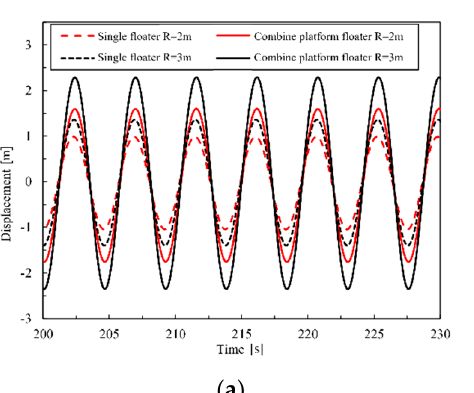
Figure 9. Motion amplitude of four groups of floater radii under regular waves with different frequencies: ( a ) R = 2 m & R = 3 m; ( b ) R = 4 m & R = 5 m.